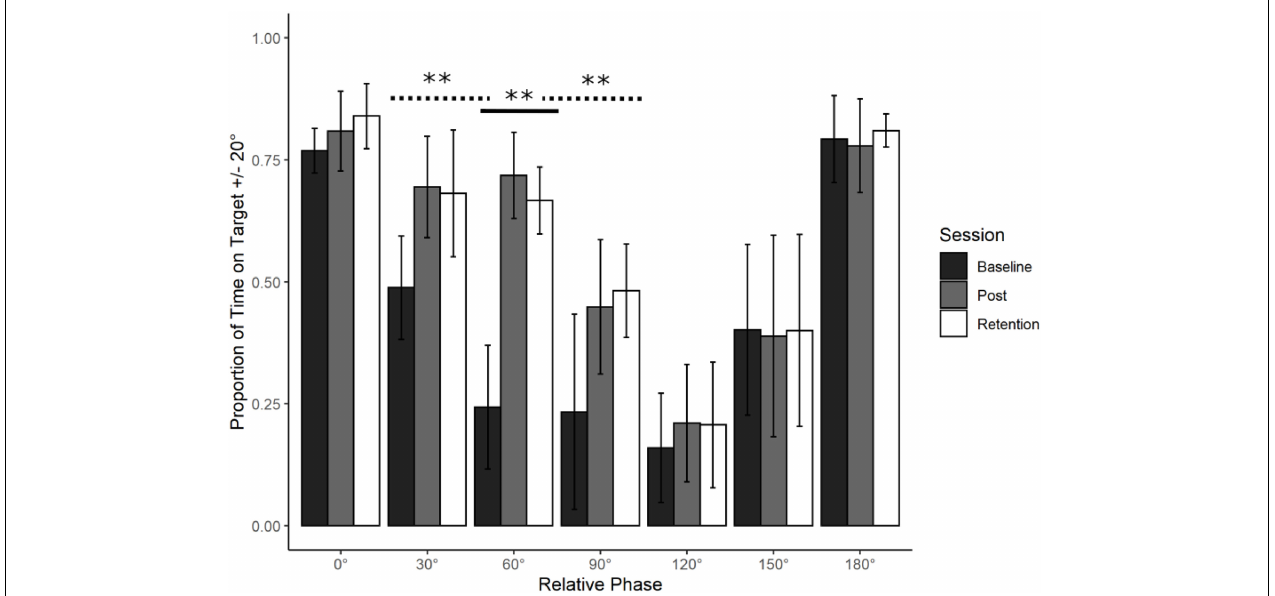
FIGURE 2 | Young adults trained at 60 ◦ : Average action data. Average performance data (Proportion of Time on Target ± 20 ◦ ) with standard error bars for all phases in the three assessment sessions (Baseline, Post Training, and Retention). Significance levels are indicated on the figure ( ∗∗ p < 0.01). There was a significant main effect of Session for the trained phase of 60 ◦ (solid line). This learning transferred to 30 ◦ and 90 ◦ (dotted lines, see Transfer section for further